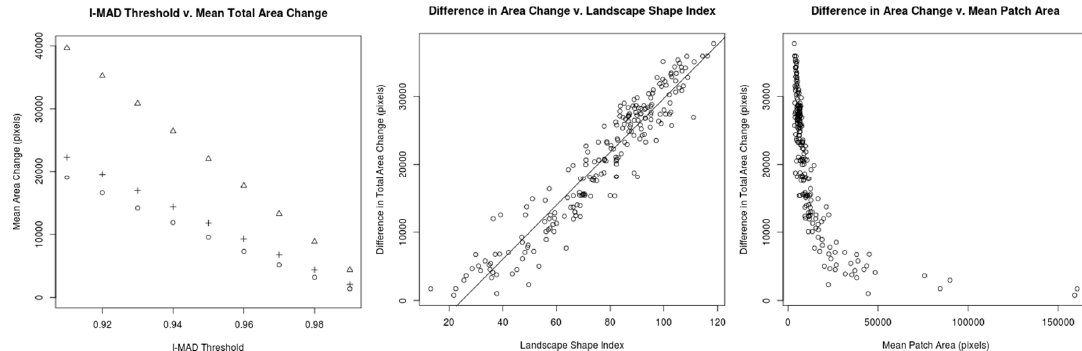
Figure 6. ( Left ) The mean area detected as change (Y-axis) over all samples using pixel-based (triangles), level-1 segments (+) and level-2 segments (circles) at increasing IR-MAD thresholds (X-axis). ( Centre ) The difference in the total area detected as change (Y-axis) between pixel and level-2 segments plotted as a function of the change segments’ landscape shape index (X-axis). ( Right ) The difference in the total area detected as change (Y-axis) between pixel and level-2 segments plotted as a function of the mean change patch area (X-axis).